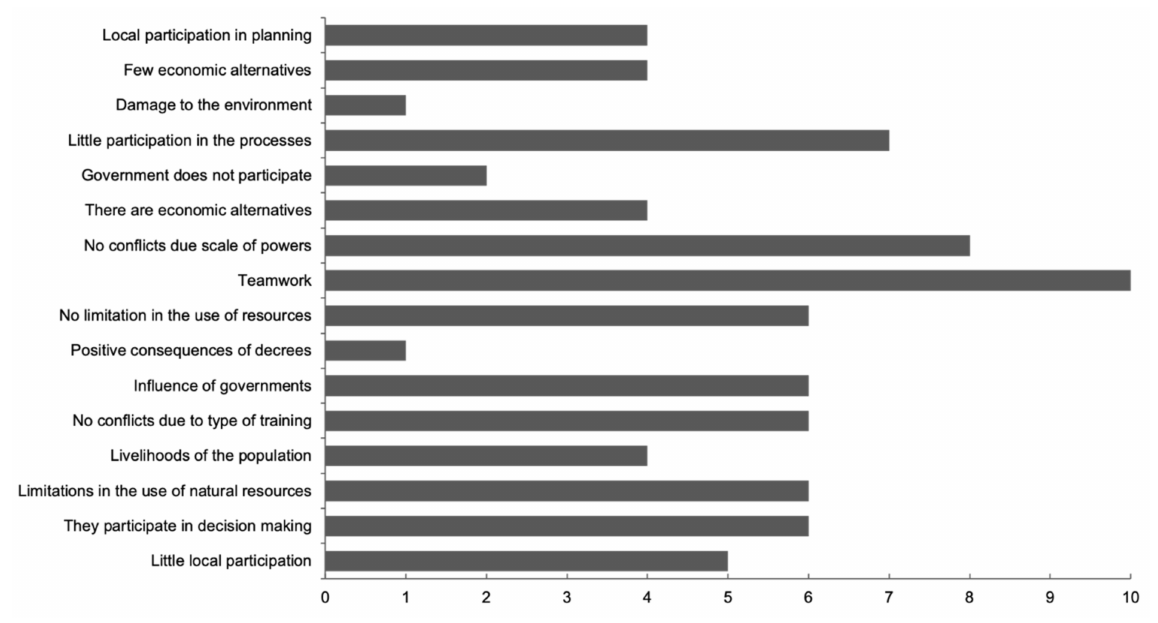
Figure 4. Frequency of responses by territorial management